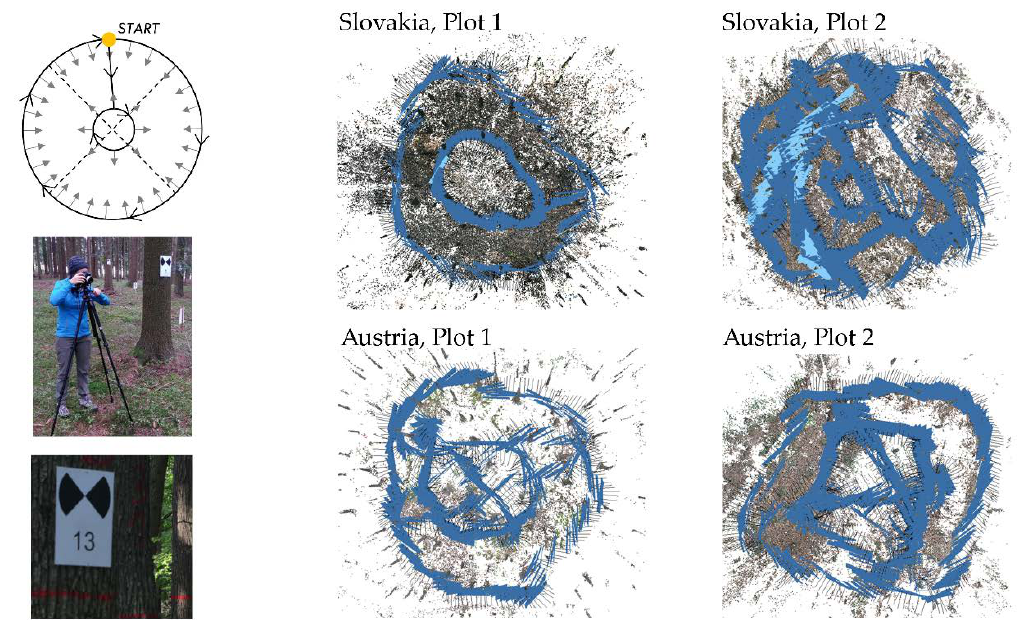
Figure A1. On the left, a schematic illustration of the photographic path, and a picture illustrating the image acquisition in the forest plot and the targets used for scaling definition and accuracy estimation of the camera orientation. On the right, the camera orientation and the tie points generated in PhotoScan for each forest plot.